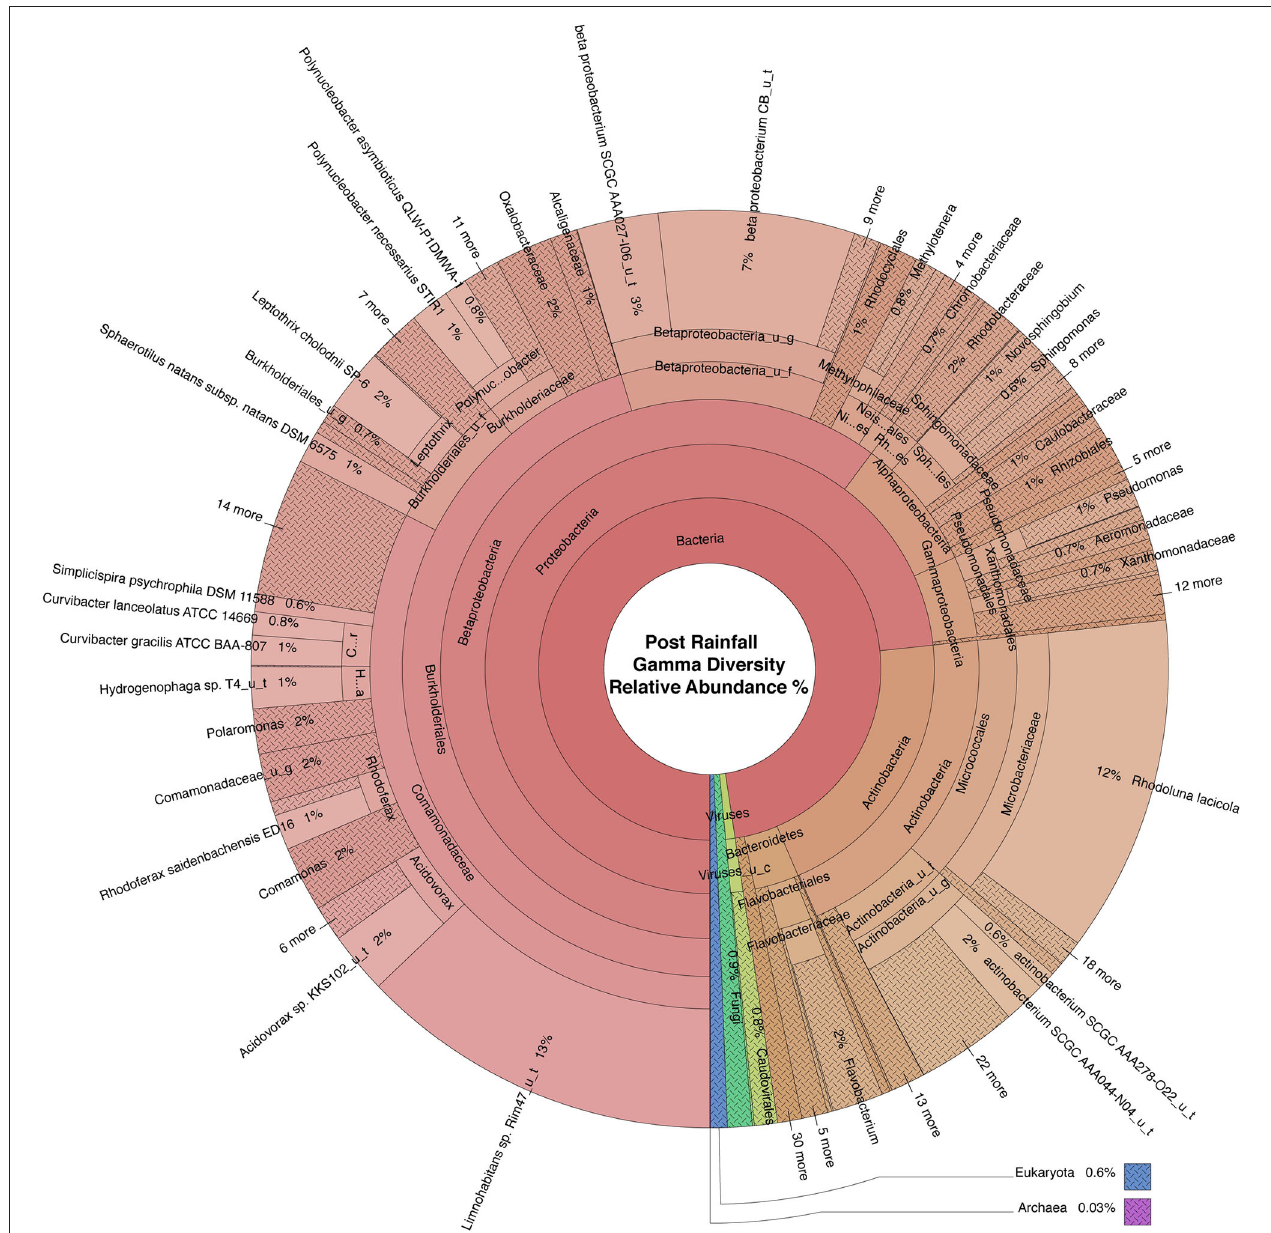
FIGURE 5 | Krona plot of the normalized water microbiome post rainfall. Species composition percentages are displayed as average number of organism specific k-mers detected, normalized to represent the proportion of organism specific k-mers observed relative to total microbial species diversity detected across samples obtained from all four locations during the sampling period following rainfall. Red, bacteria; blue, protozoa; teal, fungi; purple, archaea; green, viruses.